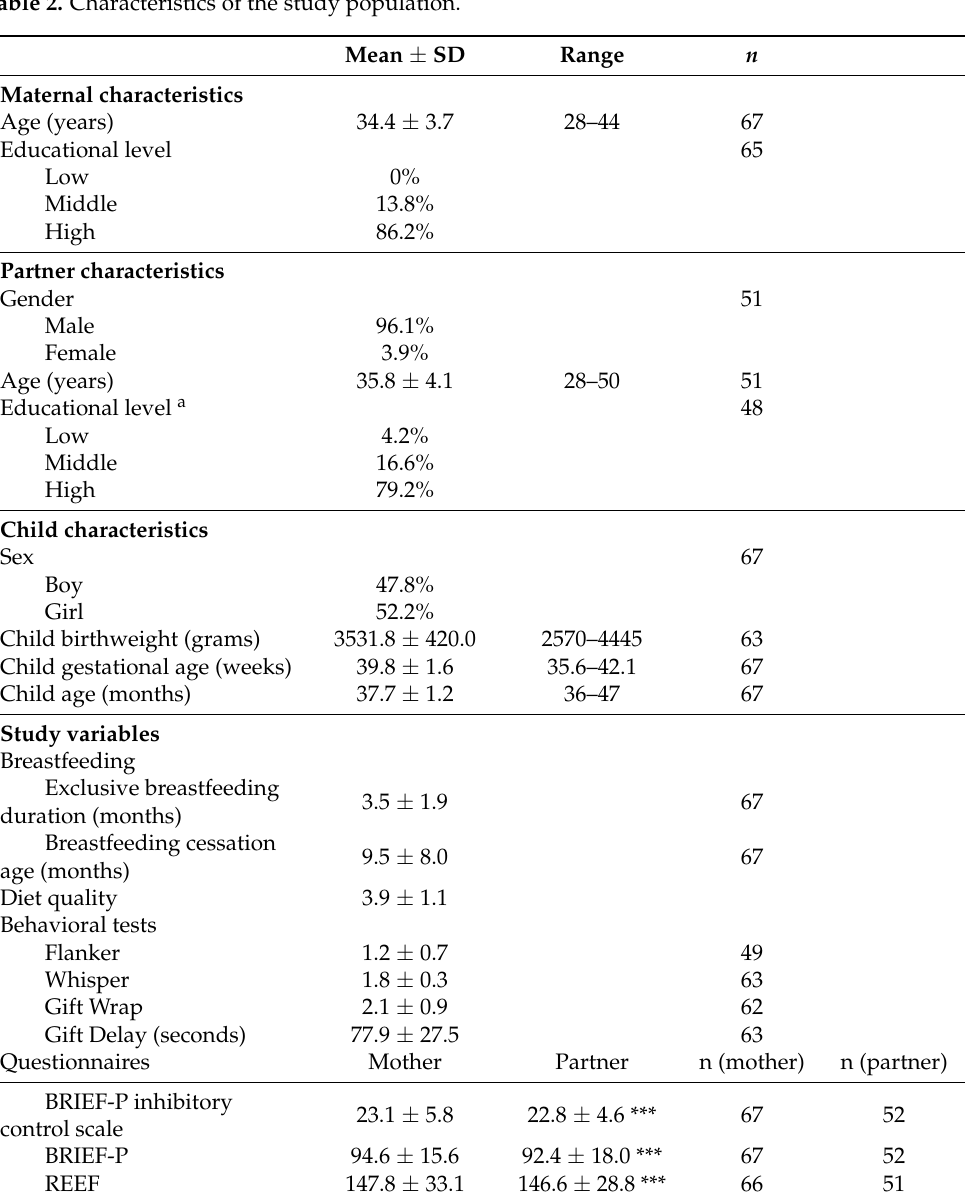
Table 2. Characteristics of the study